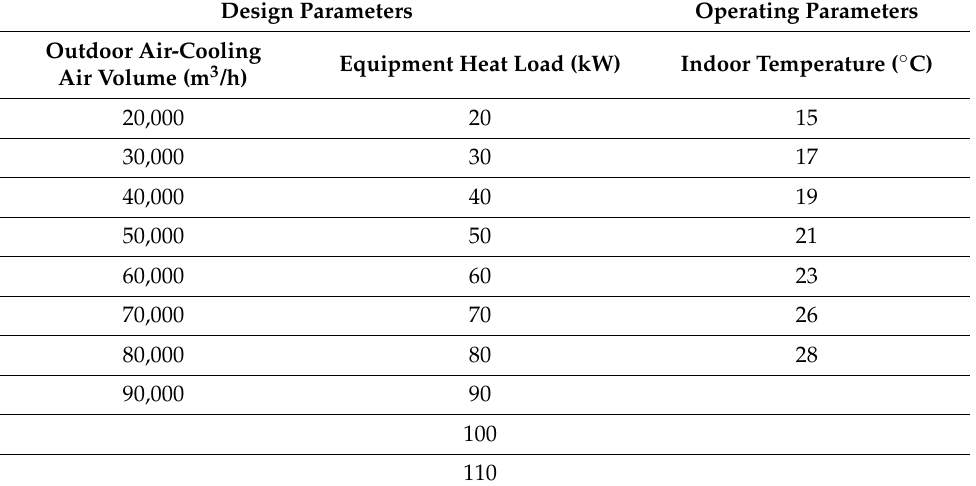
Table 4. Design and operating